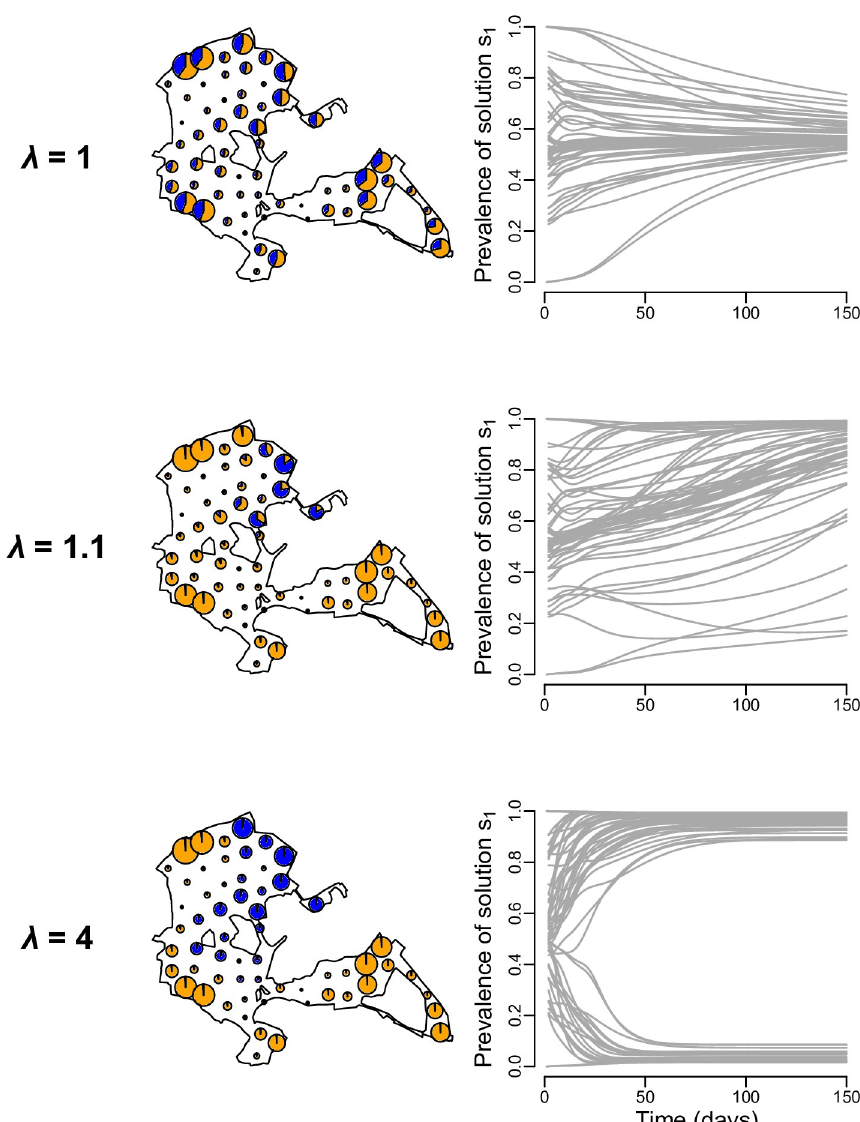
Fig 4. Predictions for the spread of information in a great tit cultural diffusion experiment in Wytham Woods. This analysis was designed to replicate the conditions of the cultural diffusion experiment performed by Aplin et al. [11], in which two alternative foraging techniques were introduced in the great tits population of Wytham Woods, United Kingdom, and their spread through time monitored. Three examples of the evolution of the prevalence of solution s 1 among solvers are shown for the movement rate (m = 0.01) and learning rate ( α = 0.007) corresponding to the model best able the replicate the empirical diffusion curves (Fig 3), but with varying conformity strength. The maps represent the extent of Wytham Woods and the location of the 60 internally sited feeders. Each feeder is represented by a pie chart indicating the number of na ï ve individuals (grey), solvers using solution s 1 (orange) and solvers using solution s 2 (blue), and the size of the pie chart is proportional to the total number individuals occurring around the feeder (i.e. the size of the sub-population). The right column shows the evolution of the prevalence of solution s 1 among solvers at each feeder (each grey line represents a feeder). When no conformity bias was included ( λ = 1) the model predicted a mixture of solutions in every sub-population; when conformity was relatively weak ( λ = 1.1) the system tended to converge towards solution s 1 dominating; and when conformity was relatively strong ( λ = 4) local traditions emerged.